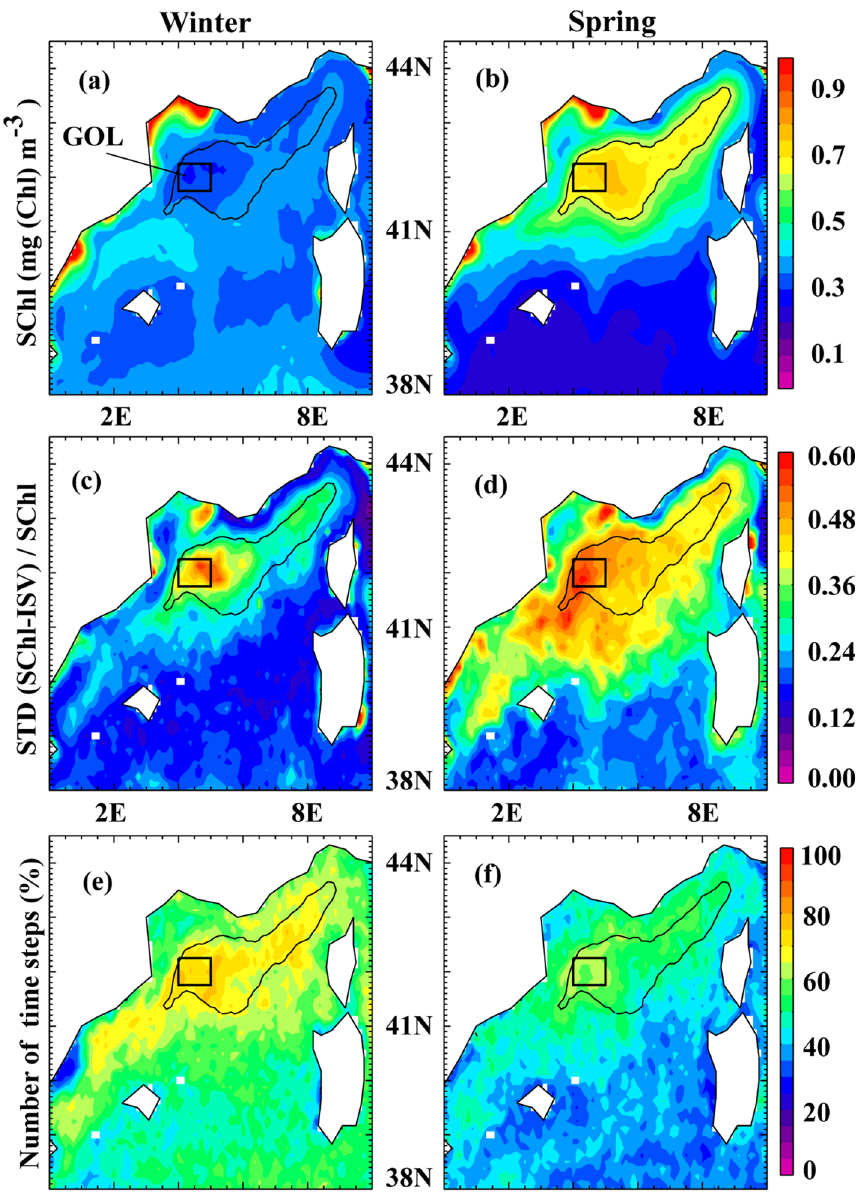
Figure 1. ( a , b ) Surface Chlorophyll climatology (SChl, in mg Chl m −3 ) in the Northwestern Mediterranean Sea in winter (January–February) and spring (March–April), over the period 1998–2017. ( c , d ) Standard deviation (STD) of intraseasonal SChl fluctuations (SChl-ISV) in winter (resp. spring), normalized by the mean SChl in winter (resp. spring). Intraseasonal SChl fluctuations were extracted from the total signal using the Census X-11 technique, following Keerthi et al. 8 . ( e , f ) Percentage of time steps for which the time derivative in Net Heat Flux and the SChl net growth rate have the same sign, during winter and during spring. In all panels, the black contour delimitates the bloom region, which we defined as the region where the climatological spring SChl is greater than 0.65 mg (Chl) m −3 . The black square marks the Gulf of Lion (GOL)